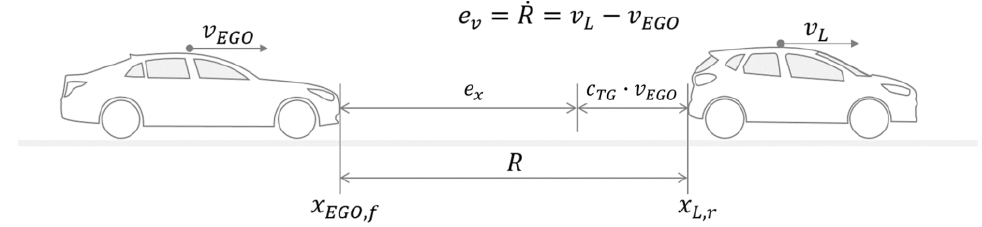
Figure 2. The scheme of error dynamics for the car-following model.